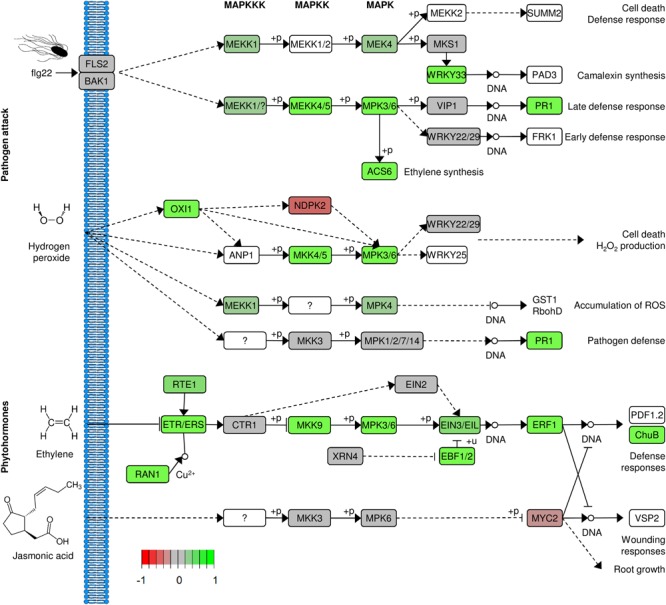
Lettuce response to S. Typhimurium 14028s. Changes in signaling pathways related to plant defense response after 24 h exposure to S. Typhimurium 14028s, compared to exposure to 10 mM MgCl2. Genes were translated to amino acid sequences and those were assigned to Arabidopsis protein orthologs. Up- and down regulated genes in the particular pathways are indicated in green and red, respectively. White background indicates genes not found in the analysis. The figure was based on KEGG and Pathview.